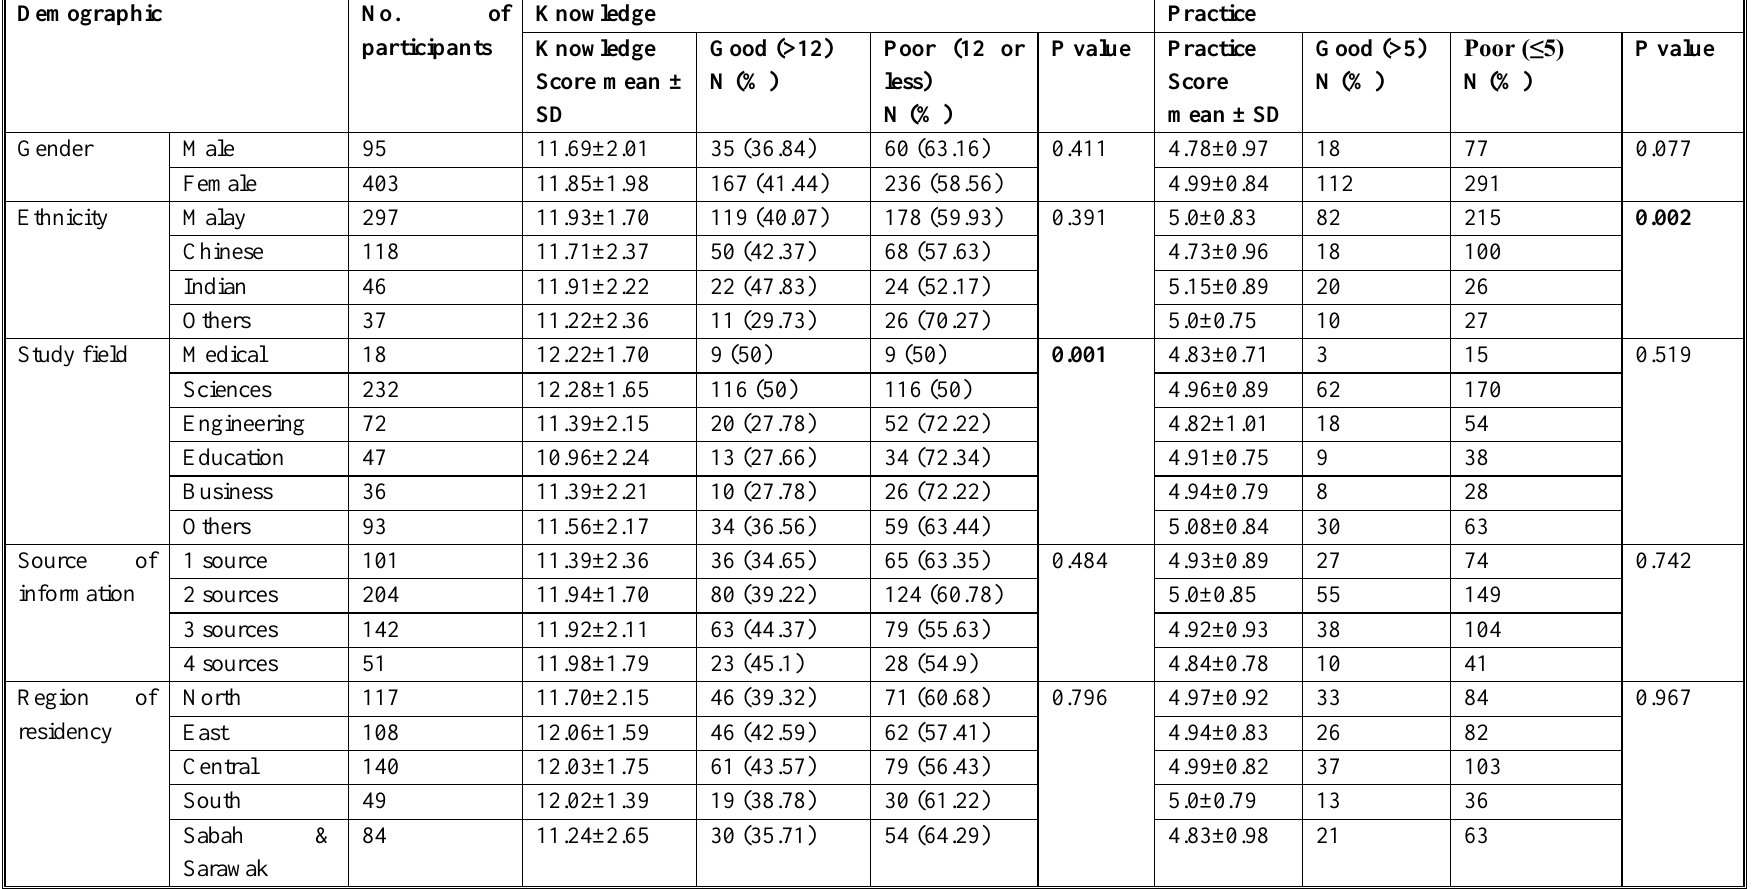
Table 4. The effect of different demographic data on students' knowledge and practice about COVID-19